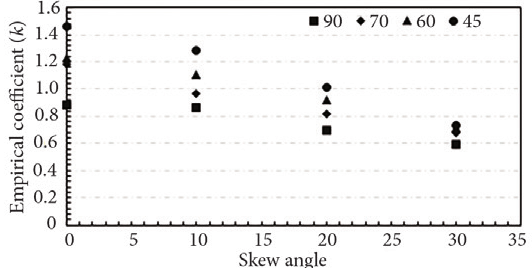
Figure 5. The empirical constantagainst a skew angle for piers with the nose